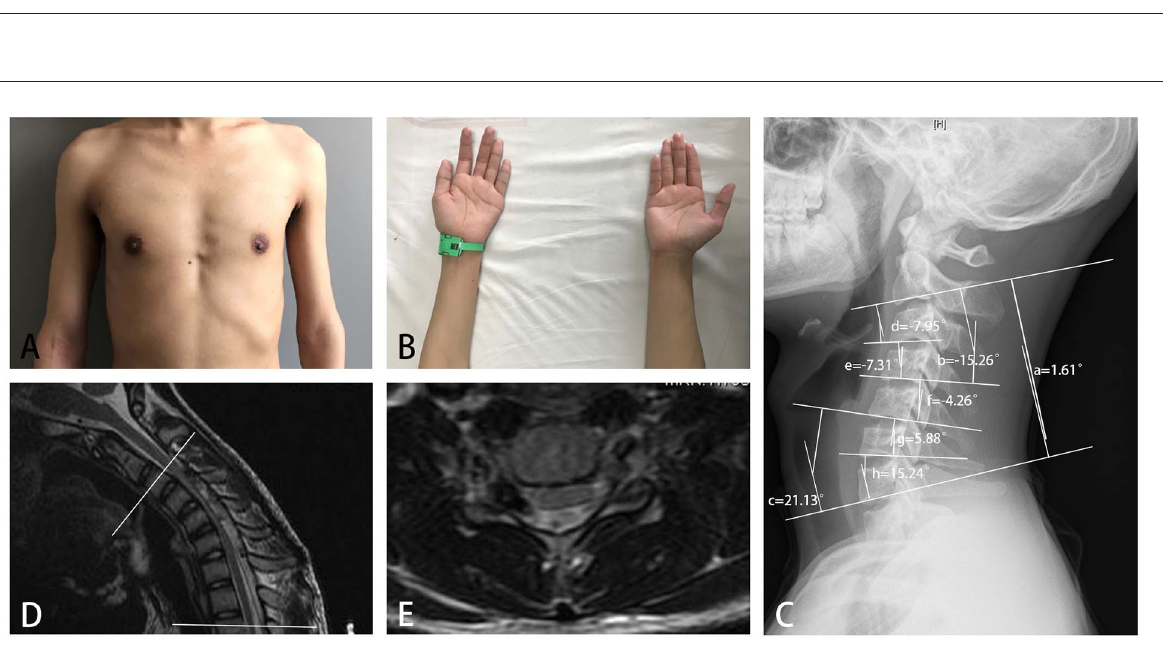
FIGURE5 A 16-year-old boy with obvious weakness and atrophy of muscles of deltoid and biceps for 3 months (A) , and slight difficulty in finger extension (B) , was diagnosed with HD with proximal involvement. A neurogenic injury from C5 to C8 was found in electromyography. (C) An abnormal cervical curvature in the upper part of the cervical spine, (a) C2-7 Cobb angle = 1.61 degrees; (b) C2-4 Cobb angle = − 15.26 degrees; (c) C5-7 Cobb angle = 21.13 degrees; (d) C2-3 Cobb angle = − 7.95 degrees; (e) C3-4 Cobb angle = − 7.31 degrees; (f) C4-5 Cobb angle = − 4.26 degrees; (g) C5-6 Cobb angle = 5.88 degrees; and (h) C6-7 Cobb angle = 15.24 degrees; loss of attachment was found in cervical-flexion MRI in seven segments from C3 to T2 (between the two white lines), (D) sagittal plane, and (E) cross-sectional